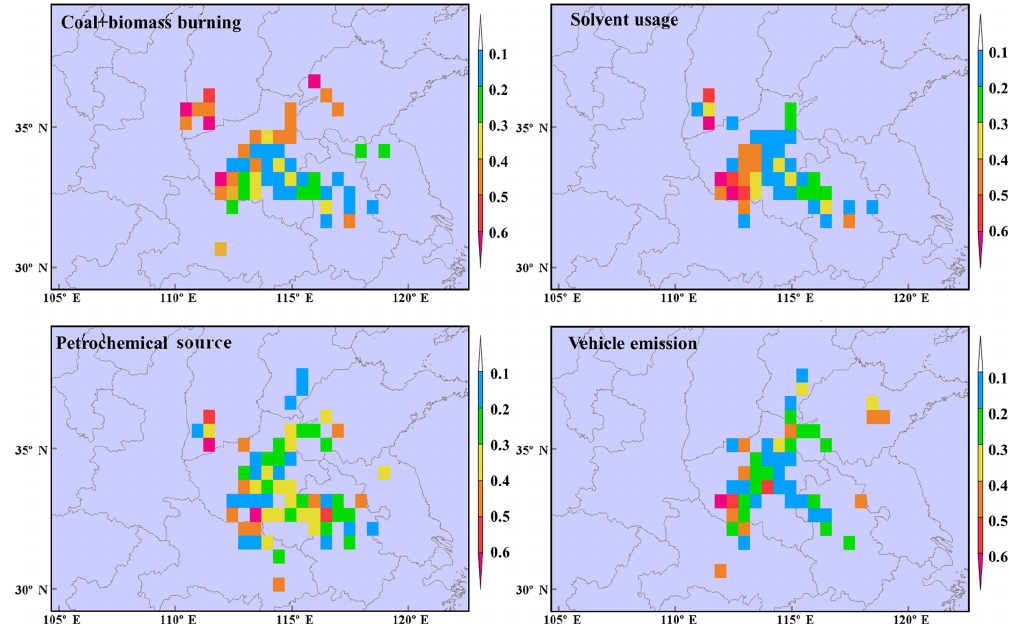
Figure 18. Probable source regions apportioned by PSCF in Zhengzhou in summer (June–August 2017) during the sampling period.